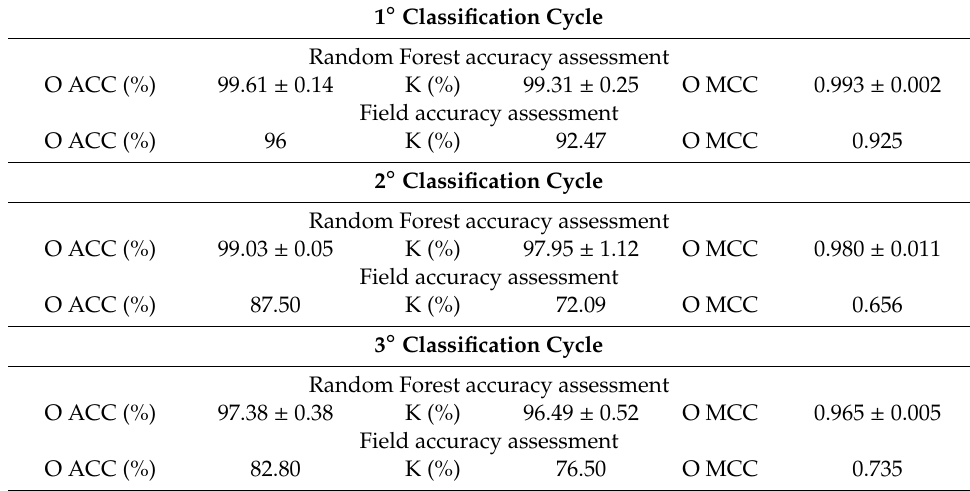
Table3. Thepercentagesofoverallaccuracyassessmentvaluesforthreeclassificationcycles,